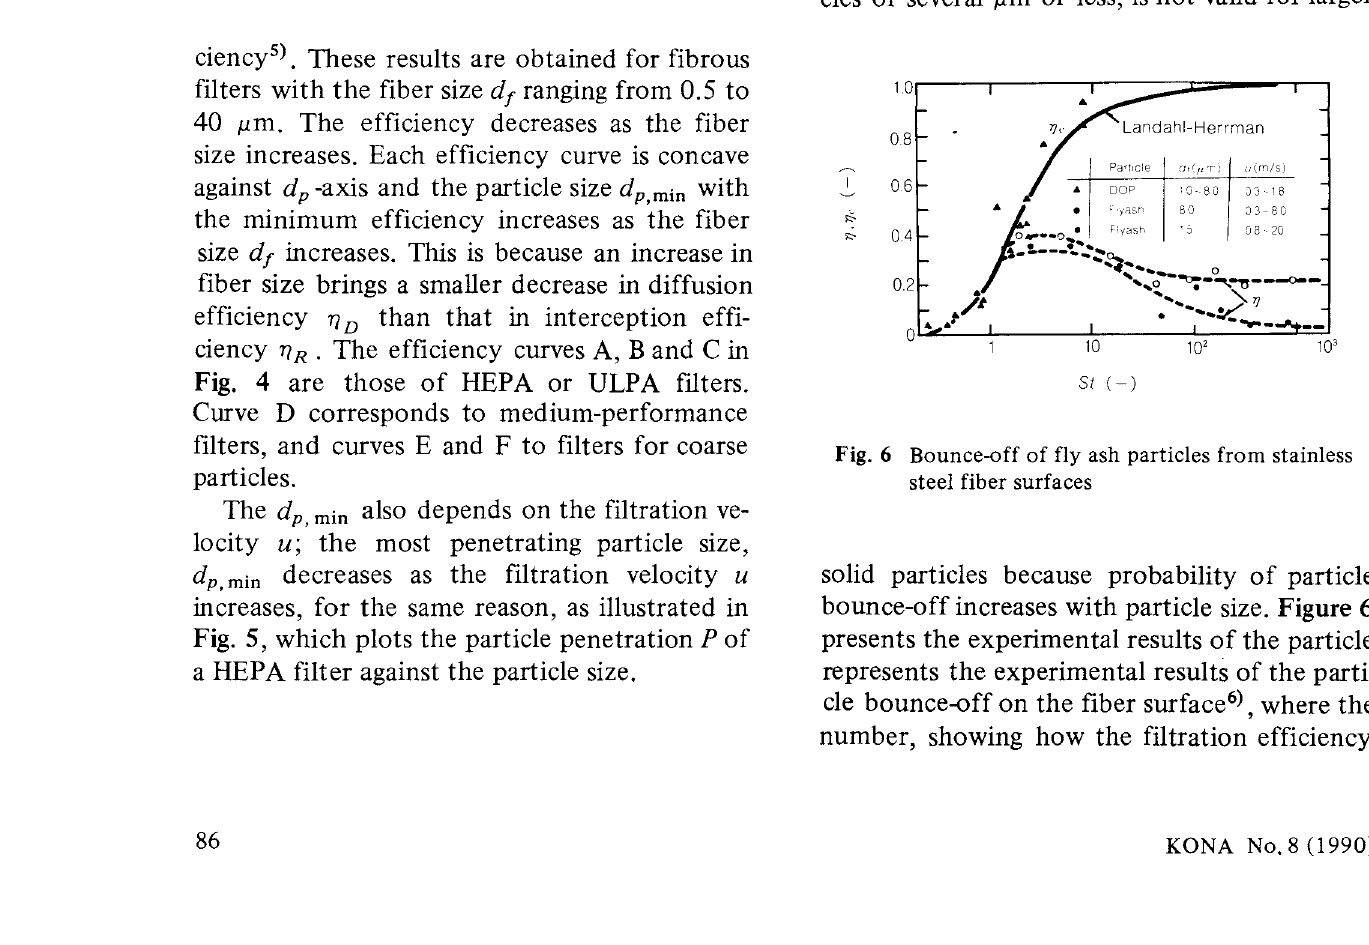
Fig. 4 Experimental single fiber collection efficiency of air filters with different sized fibers